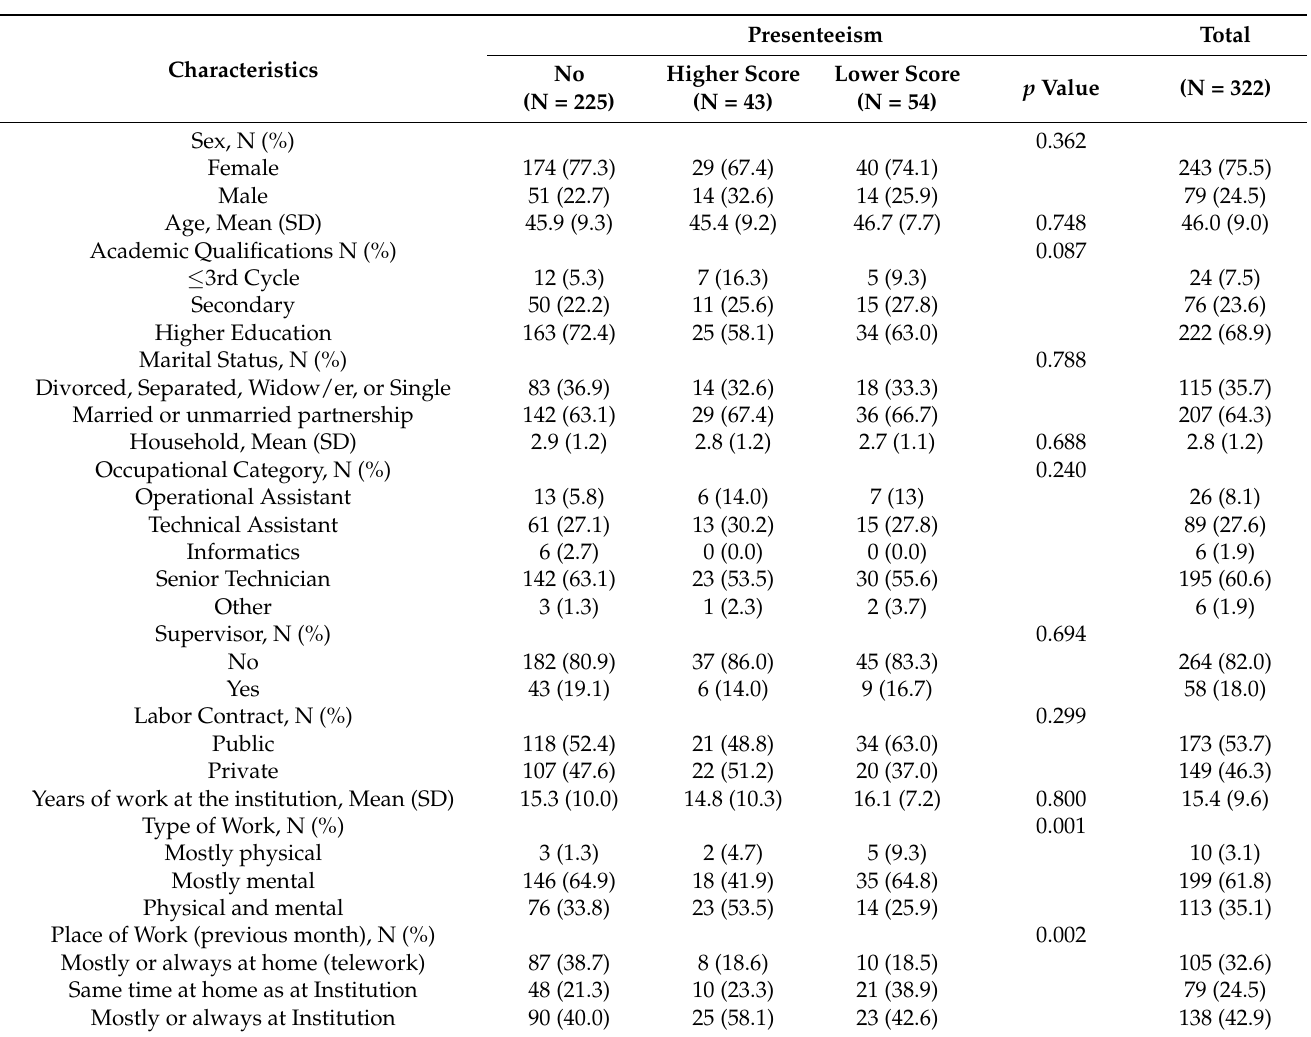
Table 1. Participants’ Characteristics by Groups of